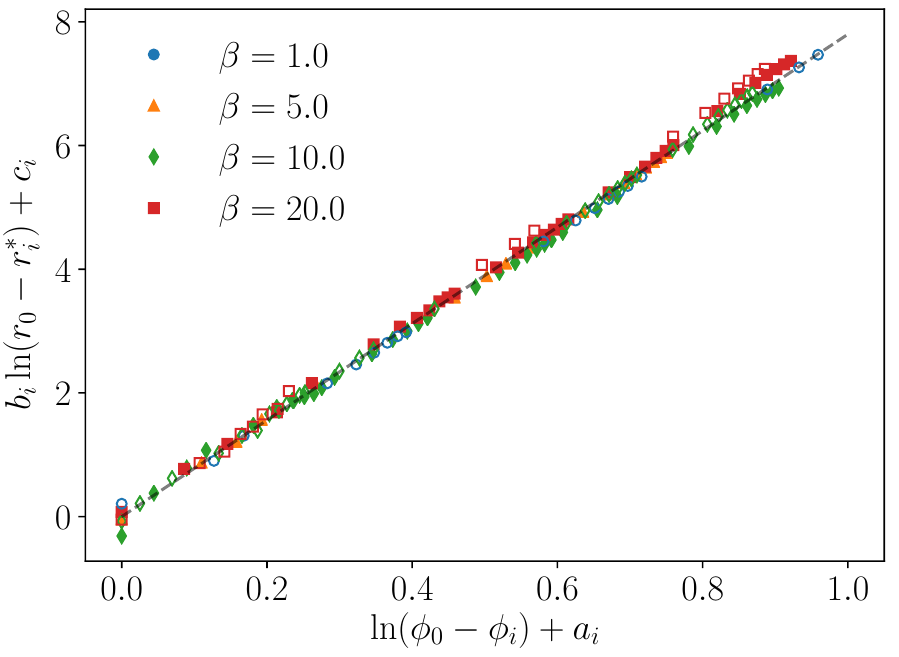
Figure 7 . Radius scaling relation of the sonic horizon for the two families of initial conditions and for various values of (cid:12) . Data with (cid:12)lled markers correspond to Family A. Data with empty markers correspond to Family